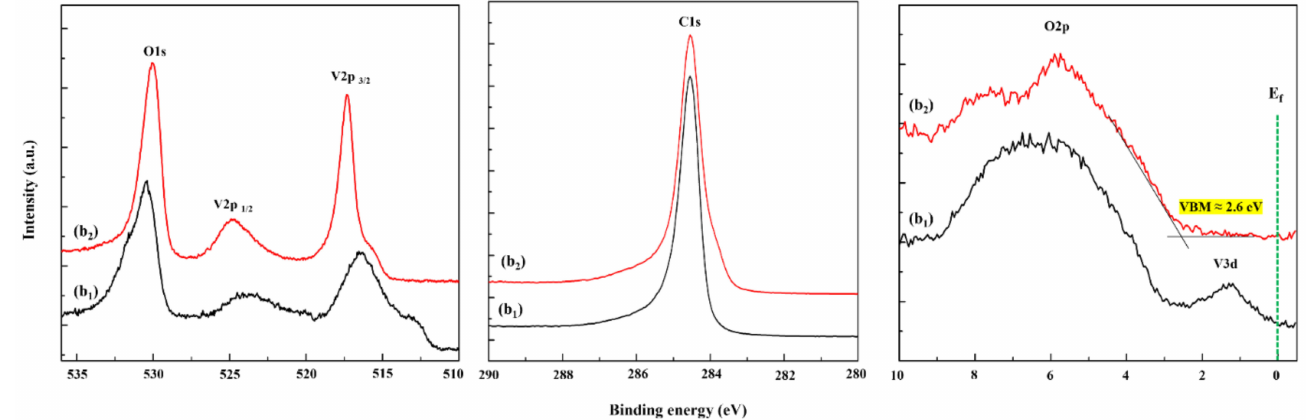
Figure 4. XPS core-level ( left ) O1s-V2p and ( middle ) C1s spectra, and ( right ) valence band spectra of sample b 1 (as-grown) and b 2